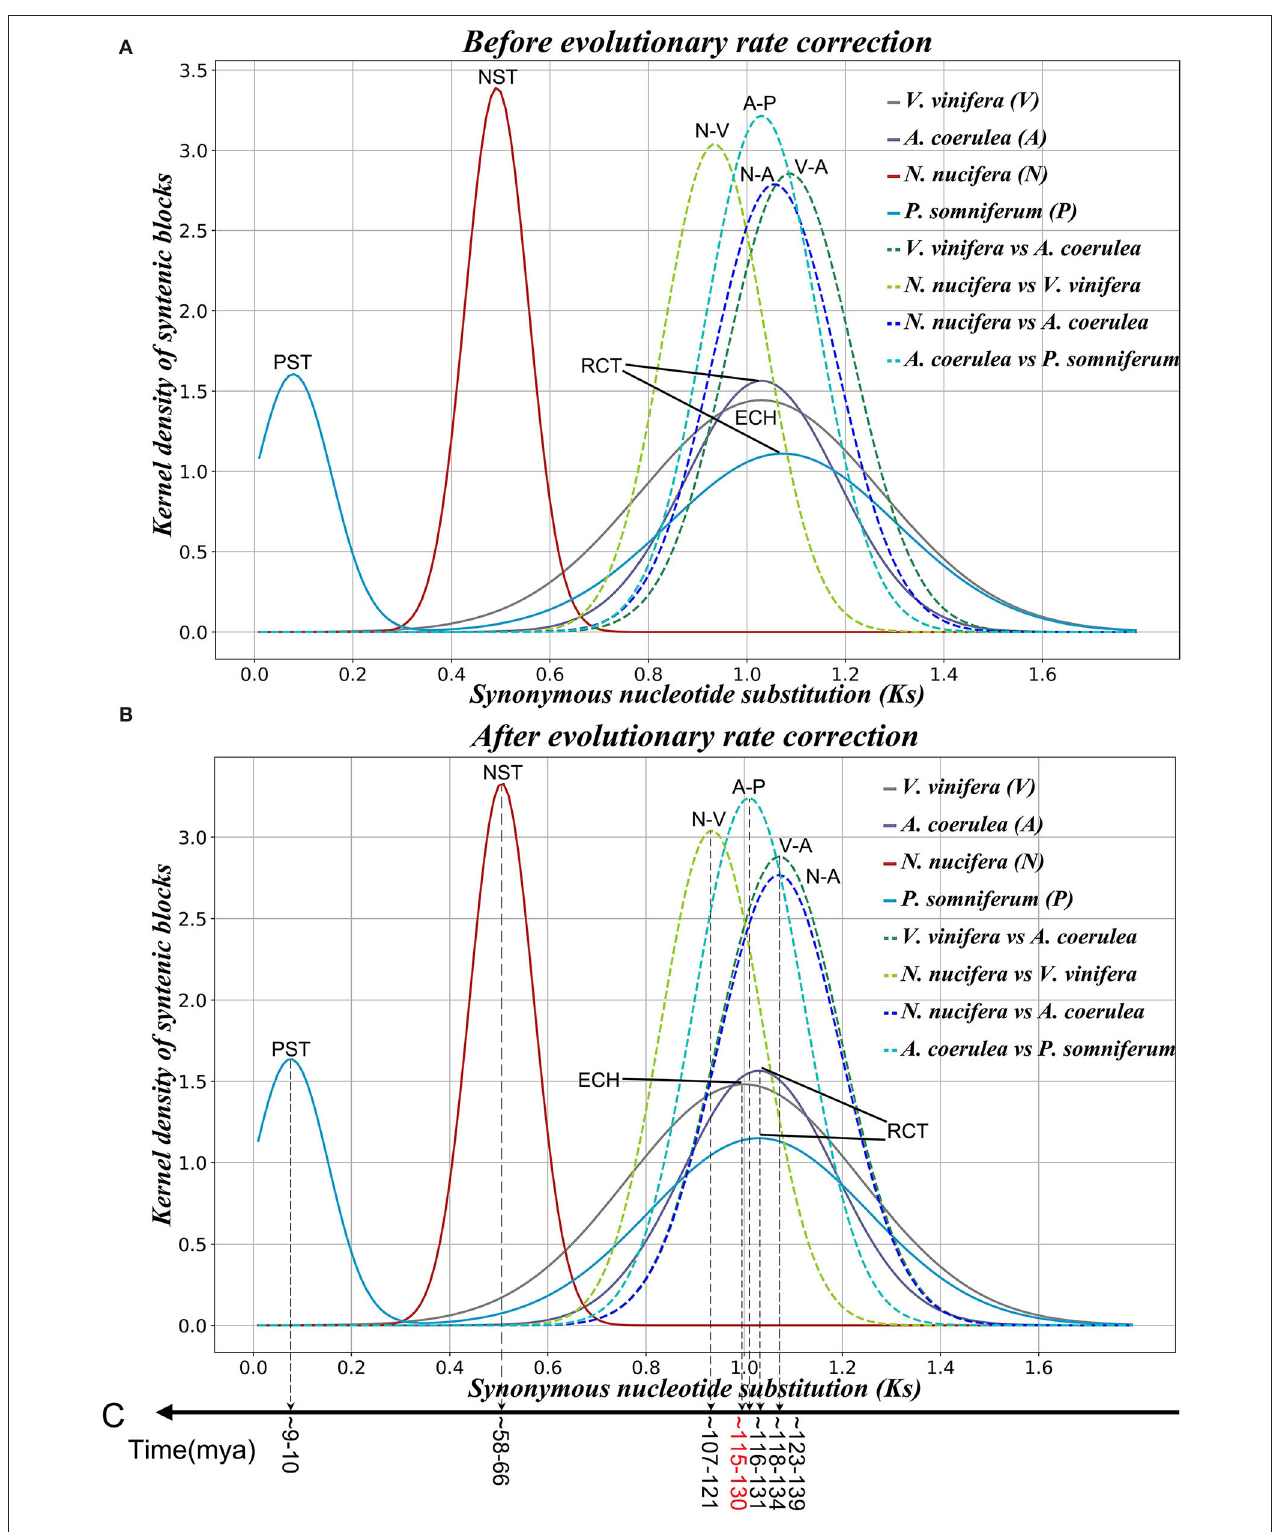
FIGURE 1 | Ks distribution of colinear genes within and among genomes. (A) Before evolutionary rate correction. (B) After evolutionary rate correction. (C) Inferred ages of key evolutionary events.